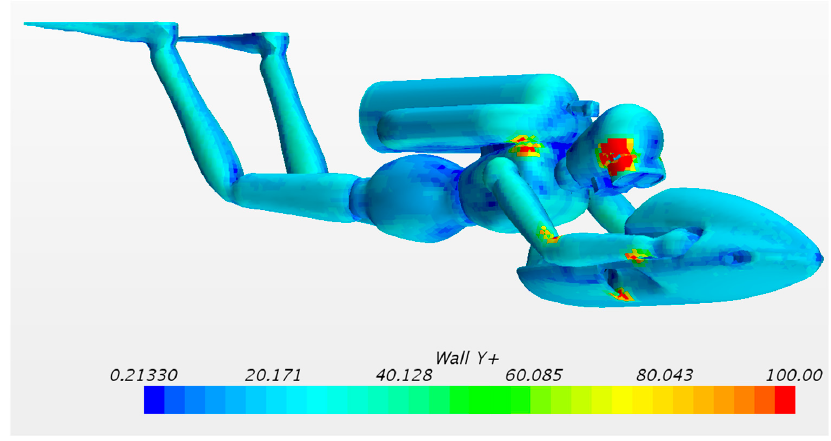
Figure 11. The case y+ distribution nephogram.